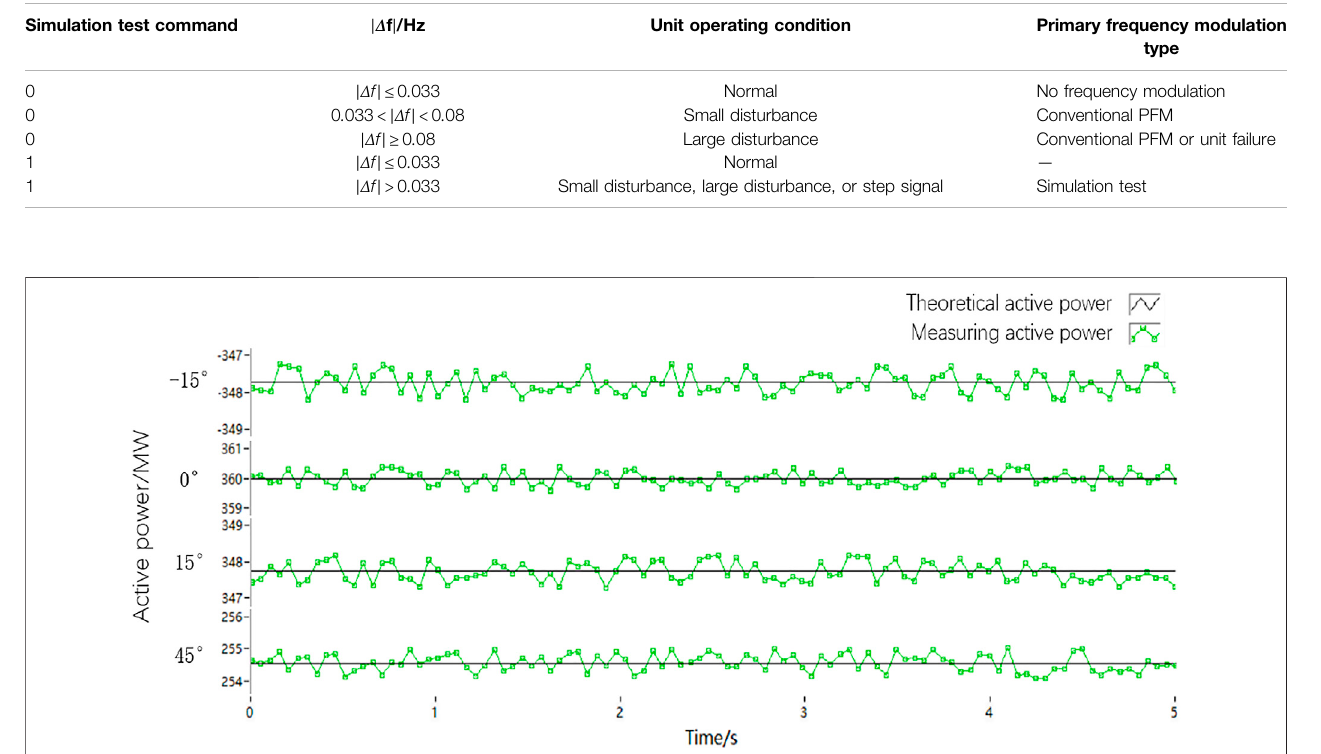
FIGURE 9 | Active power measurement fi